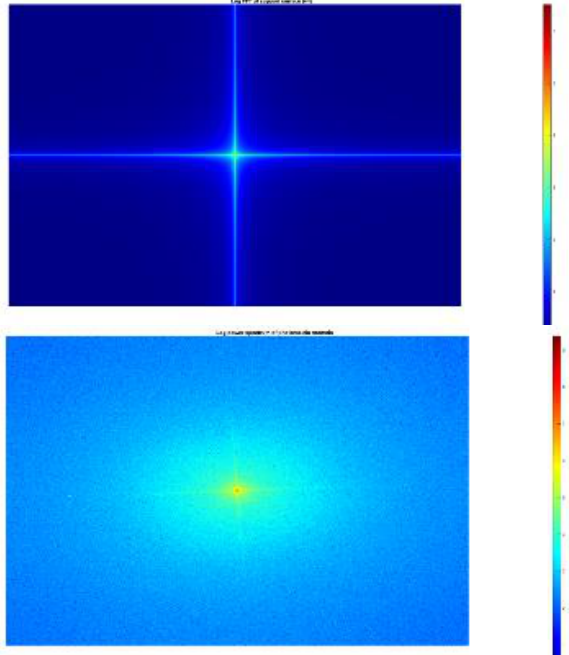
Figure 14. Log energy in Fourier domain of: (Top) the support surface, concentrated at low spatial frequencies; (Bottom) the photometric gradients, spread over all spatial